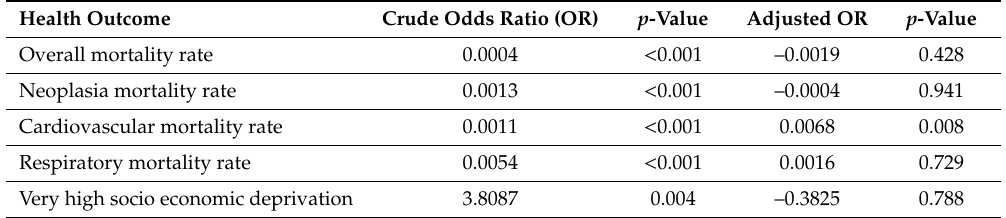
Table 4. Univariate and multivariate regression analysis of sprawl compactness score and health